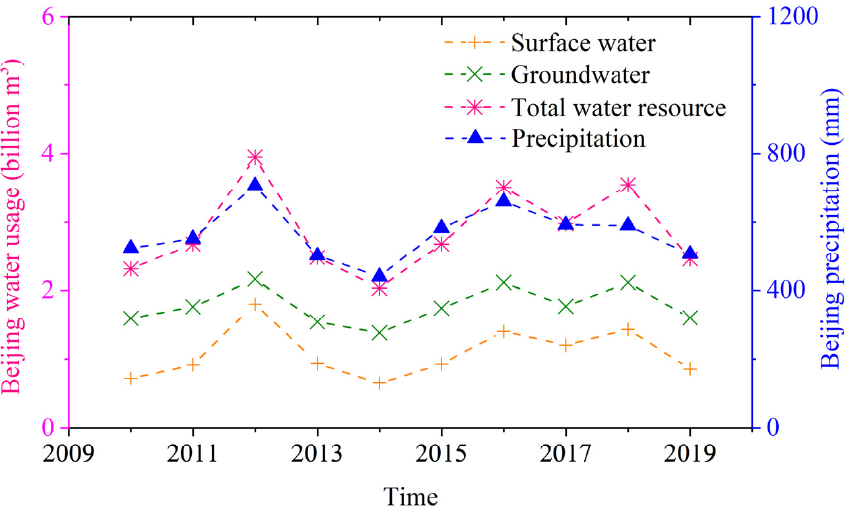
Figure 8. The relation between precipitation and total water resource. Table 3. Average groundwater level, change in groundwater storage volume and water volume of SNWDP.